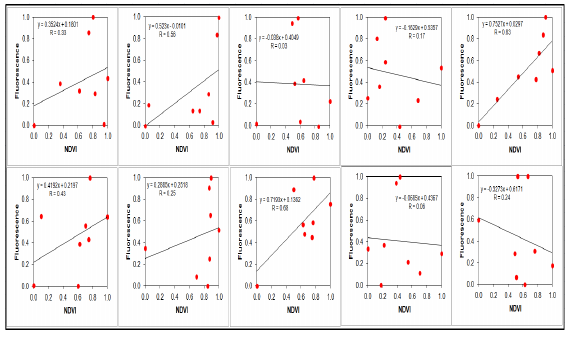
Figure 4: Relationship between NDVI and Fluorescence derived using O2A bands of Hyperion from 2012 to 2015 for sites ten vegetation